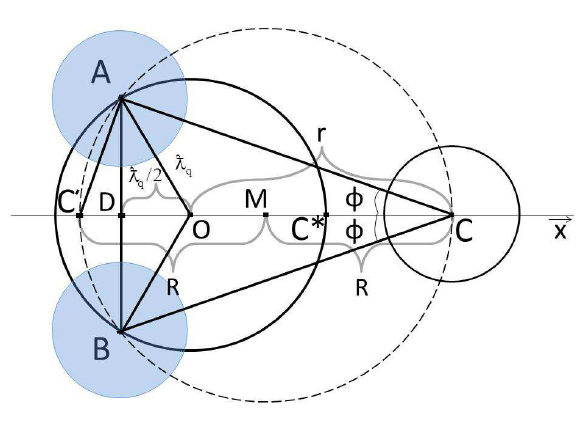
√ 3¯ λ . Particle C can move on the x q